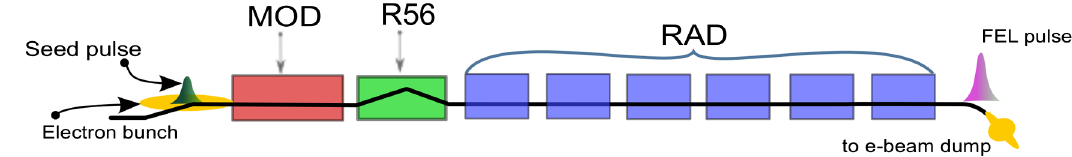
FIG. 1. Sketch of the undulators of FERMI FEL-1. The system counts a modulator (MOD), a dispersive section (R56), and six undulators define the final radiator (RAD). Between each undulator some diagnostic components, electron beam optics (quadrupoles) and phase shifter to properly set the interference between adjacent undulator are